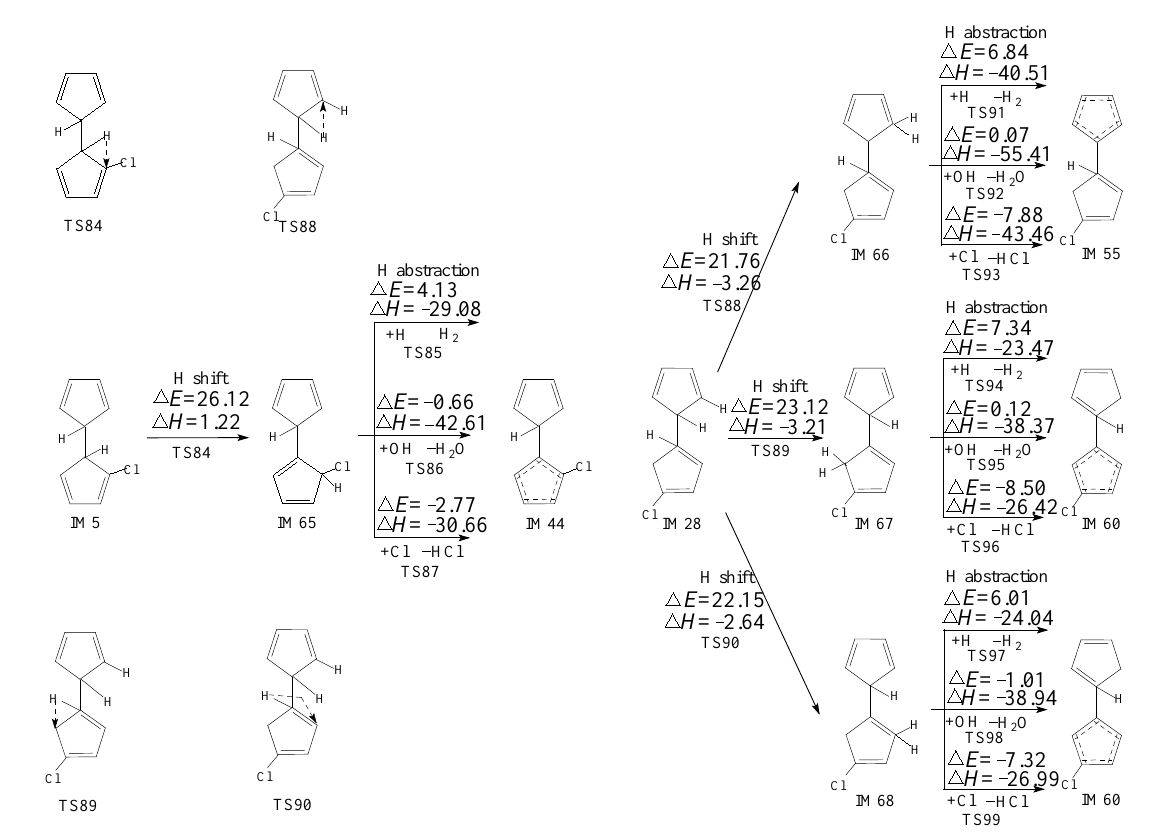
Figure 6. PCN formation routes embedded with the potential barriers Δ E (kcal/mol) and reaction heats Δ H (kcal/mol) from IM5 and IM28 starting with the H − shift step . Δ H is calculated at 0 K. Figures 1 and 2 demonstrate chloro-bicyclopentadienyl formation routes embedded with the potential barriers ∆ E (kcal/moL) and reaction heats ∆ H (kcal/moL) from the cross-condensation of PhR with 2-CPR and the cross-condensation of PhR with 3-CPR, respectively, e.g., the first process of PCN formation. All pathways include five elemen- tary steps: (1) C-C coupling; (2) first phenolic ring opening; (3) first CO elimination; (4) second phenolic ring opening; (5) second CO elimination. The first/second CO elimina- tion step is a synergetic reaction, e.g., CO loss and five-member ring formation occur at the same time. The C-C coupling step is barrierless and strongly exothermic, which is ortho – ortho coupling of CPRs to form an o,o’-dihydroxybiphenyl (DOHB) intermediate. As shown in Figure 1, three chloro-bicyclopentadienyls (IM5 and IM13) from four possible pathways (pathways 1–4) are proposed from the cross-condensation of PhR with 2-CPR. In Figure 1, in the first step of pathways 1 and 2, the coupling of two carbon (hydrogen)-centered radical mesomers (CH/CH) forms DOHB intermediate IM1, which finally produces IM5 with two ortho carbons connected by H, as shown in Figure 1. In the first step of pathways 3 and 4, the recombination of the carbon (hydrogen)-centered radical mesomer with the carbon (chlorine)-centered radical mesomer (CH/CCl) forms DOHB intermediate IM9, resulting in IM13 with one ortho carbon connected by H and another with Cl. In Figure 2, three chloro-bicyclopentadienyls (IM5 and IM28) from four possible pathways (pathways 5–8) are proposed from the cross-condensation of PhR with 3-CPR. All four pathways start with CH/CH coupling. Pathways 5 and 6 occur via the same DOHB intermediate IM17 and form the same chloro-bicyclopentadienyl intermediate IM5. Pathways 7 and 8 occur via the same DOHB intermediate IM24 and form the same chloro-bicyclopentadienyl intermediate